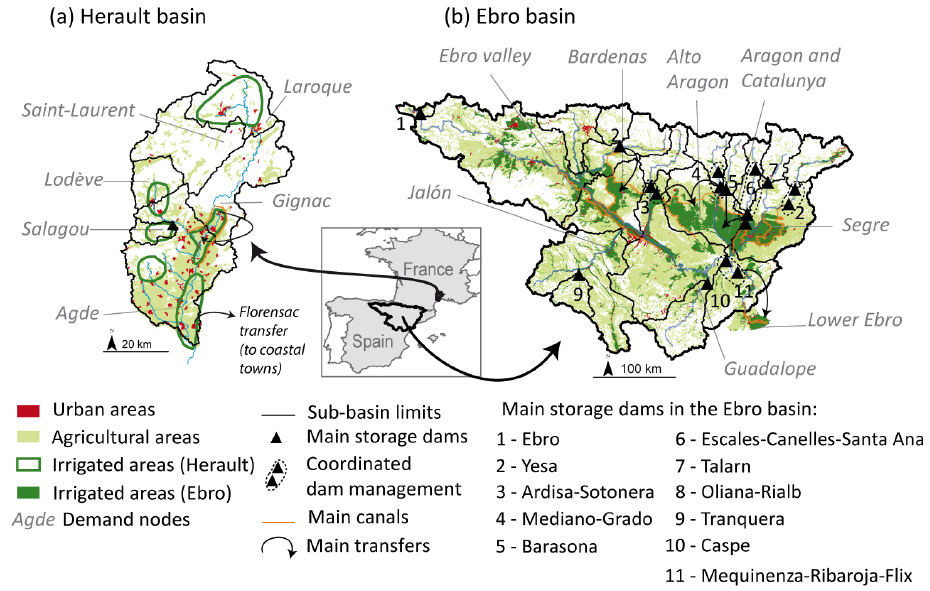
Figure 1. Location, main water uses and water management characteristics of (a) the Herault and (b) the Ebro basins. In the Herault basin, six sub-basins matching six demand nodes were defined. In the Ebro basin, 20 sub-basins were selected for the simulation of water resources and eight demand nodes matching the main irrigation systems were defined. Modified from Fabre et al.